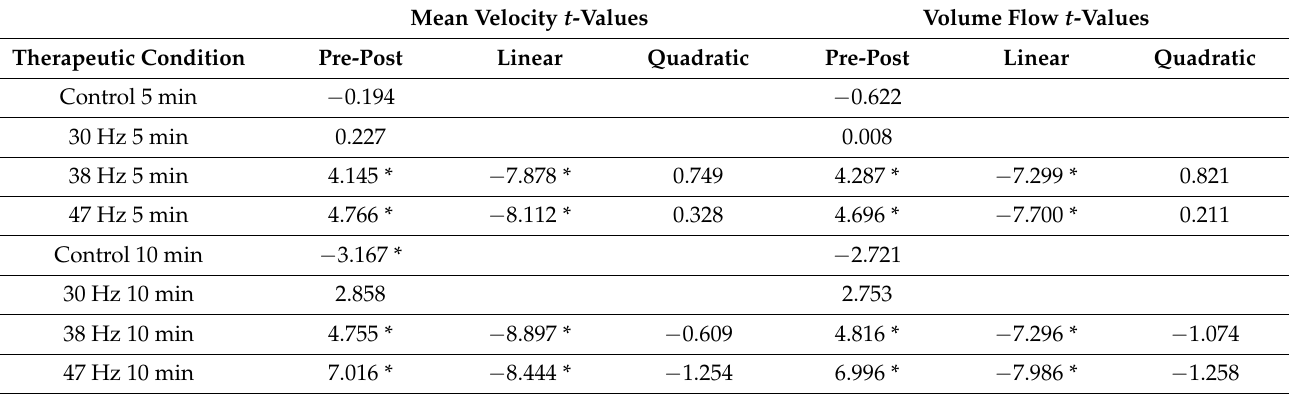
Table 1. T -values for pre- and post-vibration effect, linear effect, and quadratic effect of recovery for both mean velocity and volume flow of each condition. The corrected t -value for significance is greater than | ± 2.99|. Mean Velocity t -Values Volume Flow t